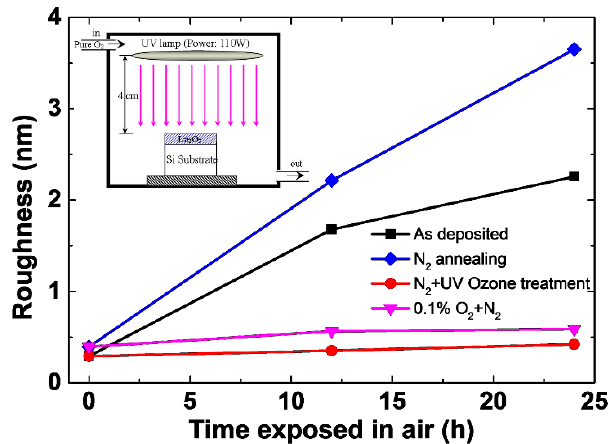
Figure 7. Roughness of La 2 O 3 with different post-deposition treatments vs. exposure time in air [43].